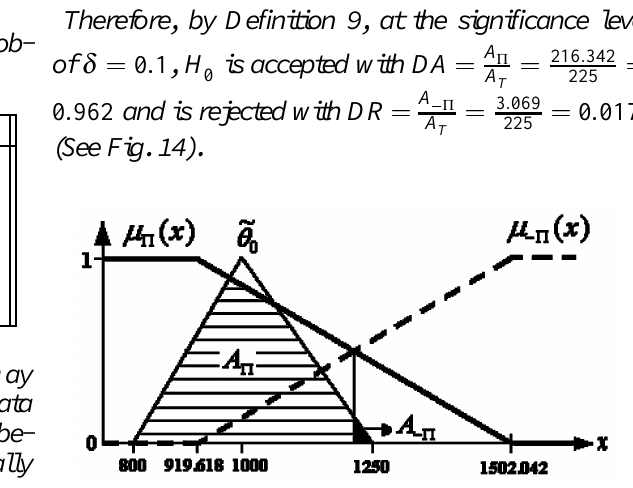
0 962 ( DR (cid:2) (cid:0)